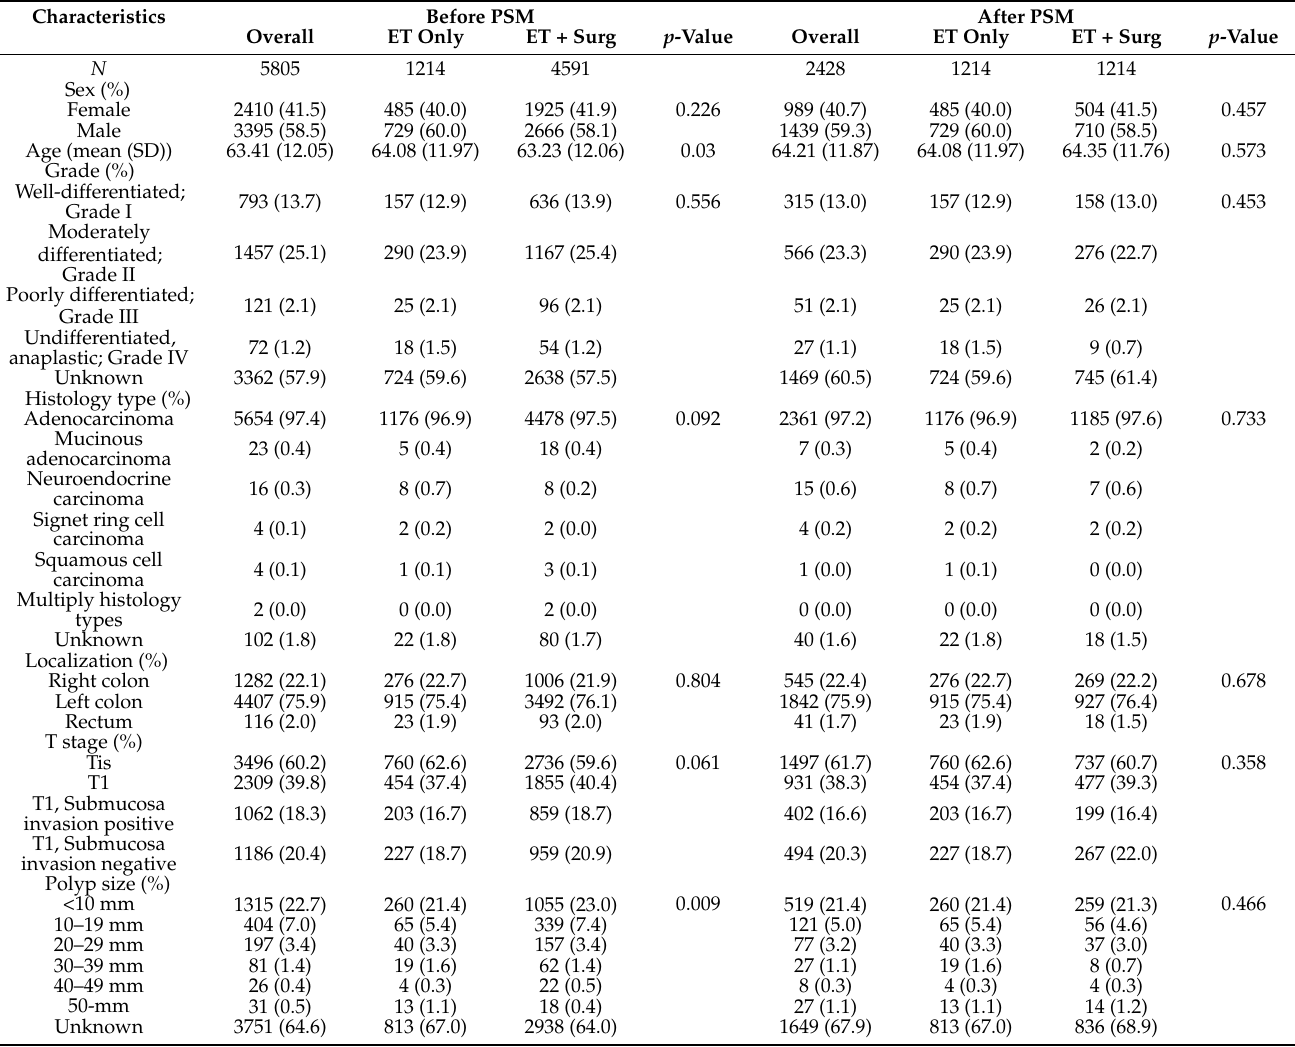
Table 1. Baseline characteristics before and after propensity score matching